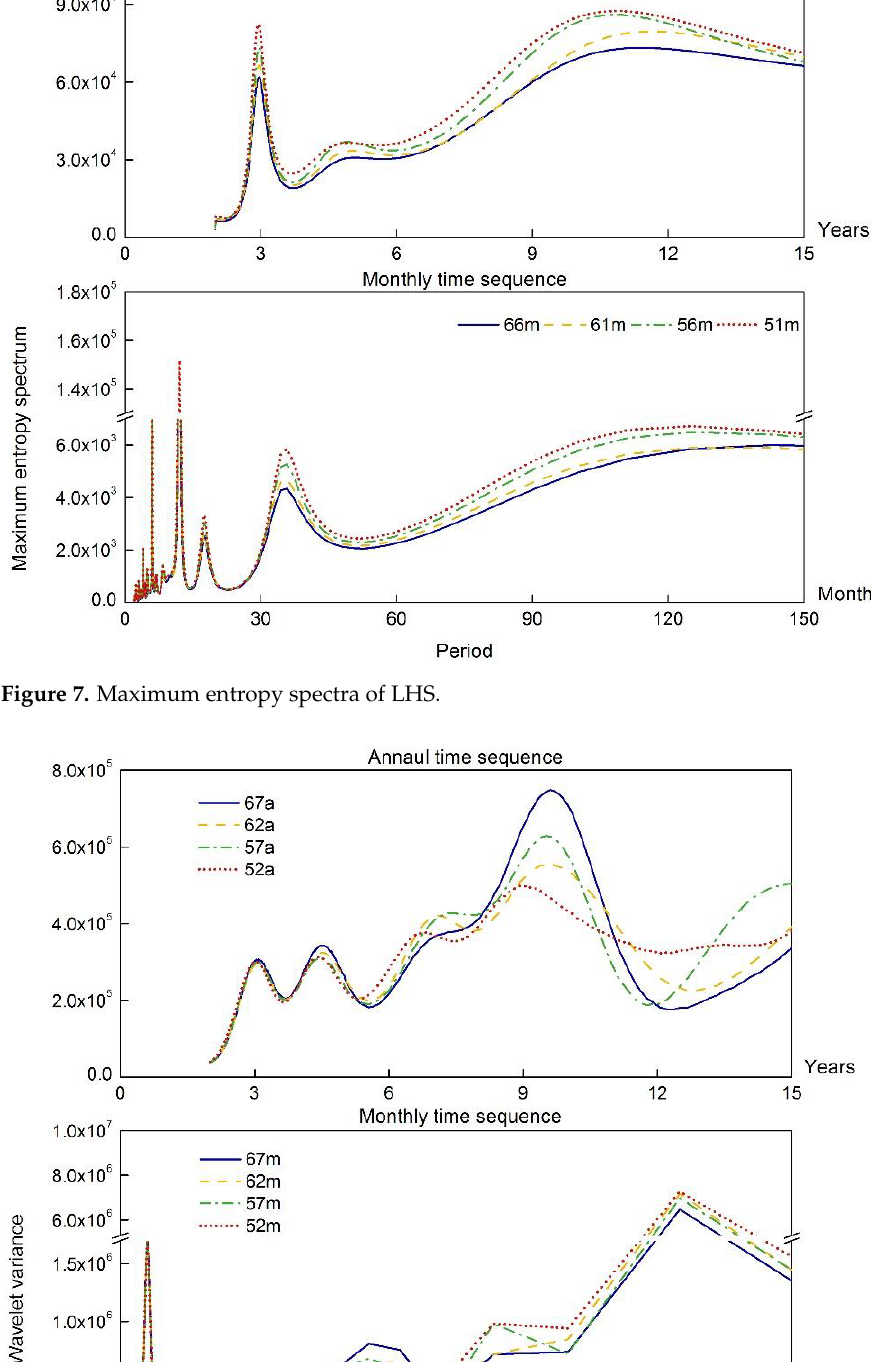
Figure 6. Maximum entropy spectra of HHS.